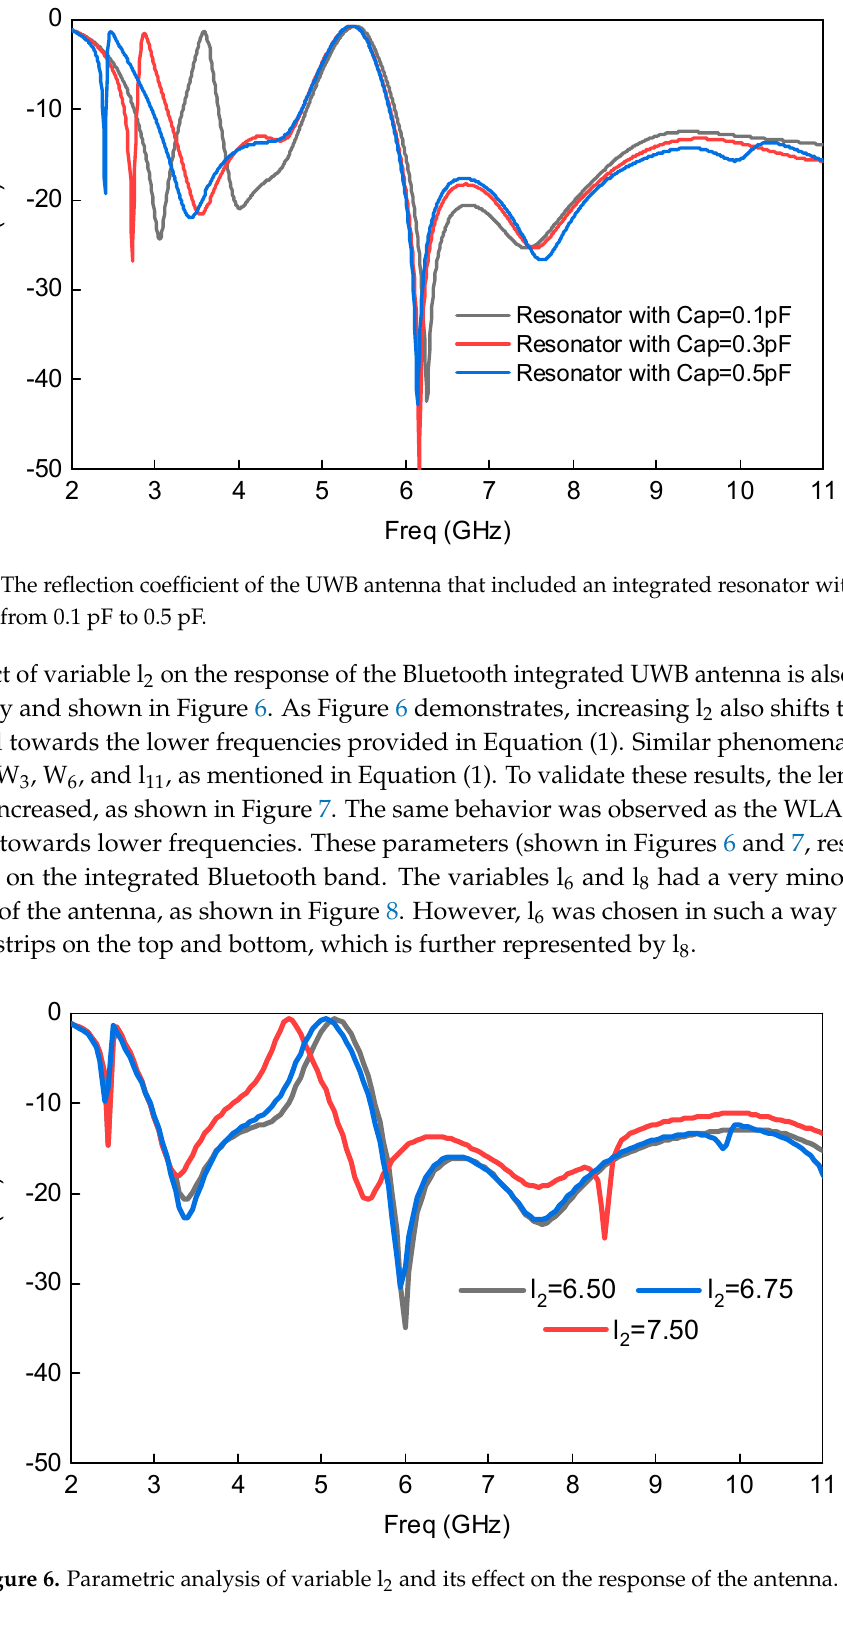
Figure 6. Parametric analysis of variable l 2 and its effect on the response of the antenna.